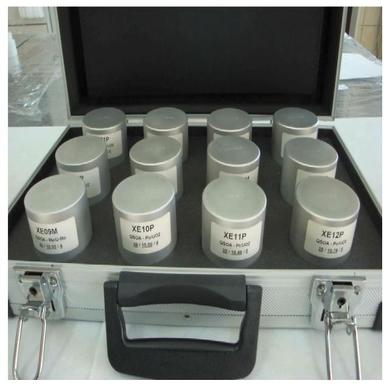
A set of uranium-bearing materials in various shapes made in Kharkov Institute of Physics and Technology.